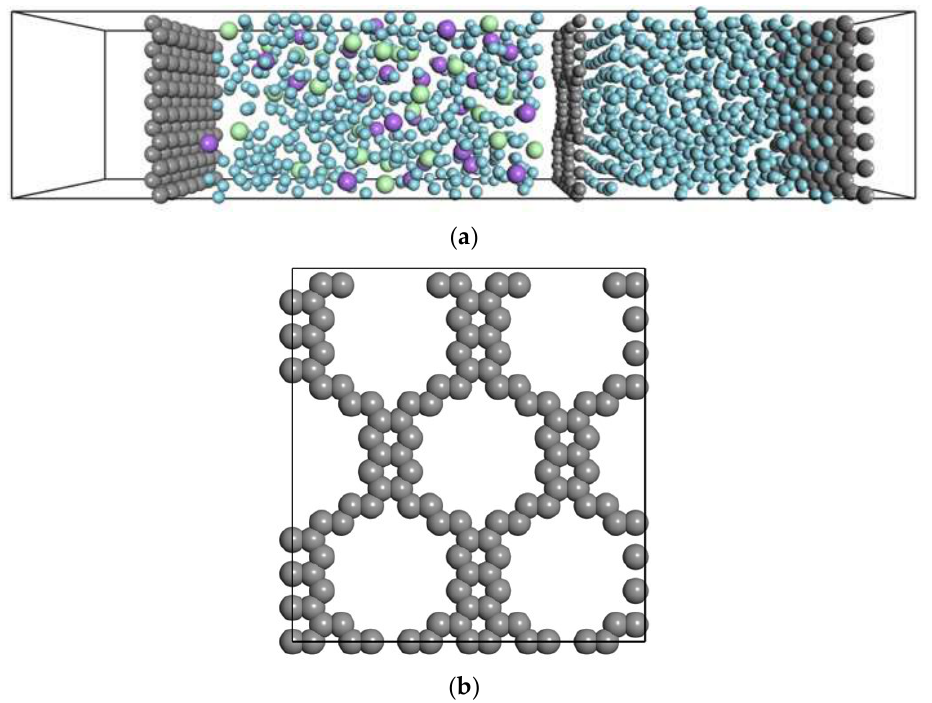
Figure 1. ( a ) Side view of the unit cell for the representative model of FO containing 9.1% solute and ( b ) model of the M Ar membrane. The light blue, gray, green, and purple spheres represent S Ar, M Ar, and Ar wall, the solute (Na), and the solute (Cl), respectively.